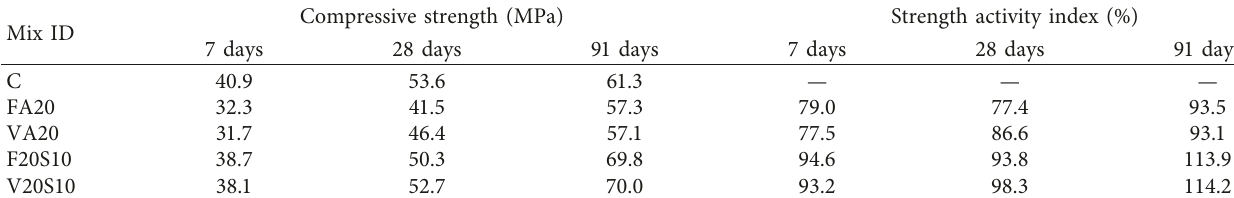
Table 5: Compressive strength and strength activity index values with respect to